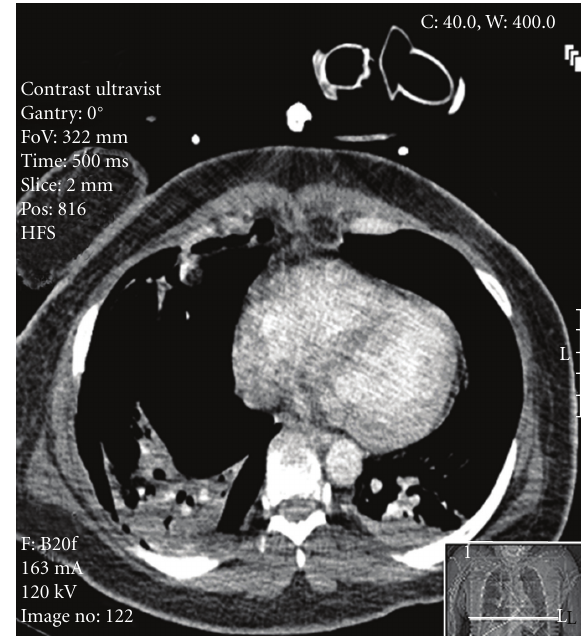
Figure 2: Extensive bilateral